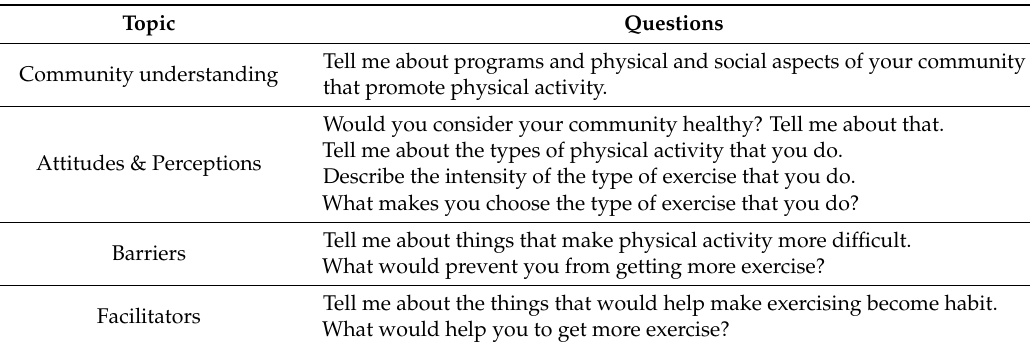
Table 2. Focus group guide questions related to physical